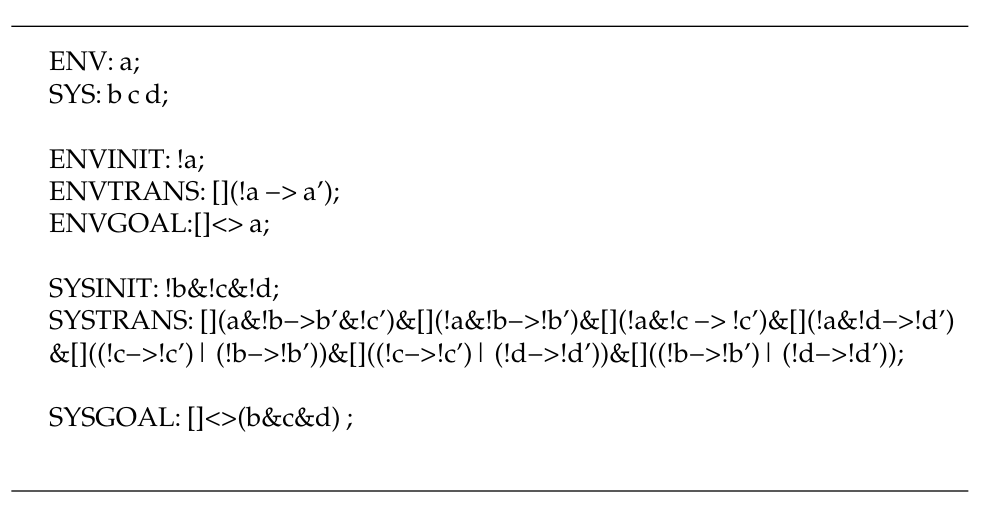
Figure 2. The GR(1) specification used in the example